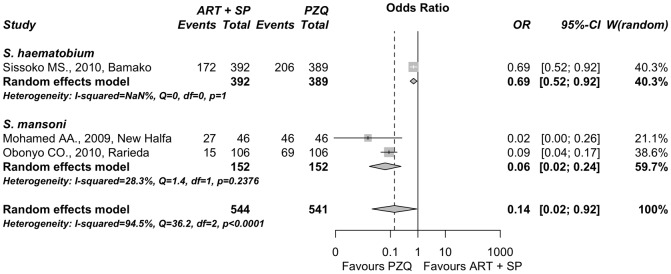
Forest plot of the random-effects subgroup meta-analysis comparing parasitological cure by artesunate plus sulfadoxine/pyrimethamine vs. praziquantel.Points represent odds ratios with their corresponding 95% C.I. Intermediate diamonds are combined odds ratios for each subgroup and the diamond at the bottom is the overall combined odds ratio. The vertical line emphasizes an odds ratio = 1 (no difference) and the dashed vertical line shows the value of the overall combined odds ratio. The original reports are labeled with author name, year and location (for details see table 3).